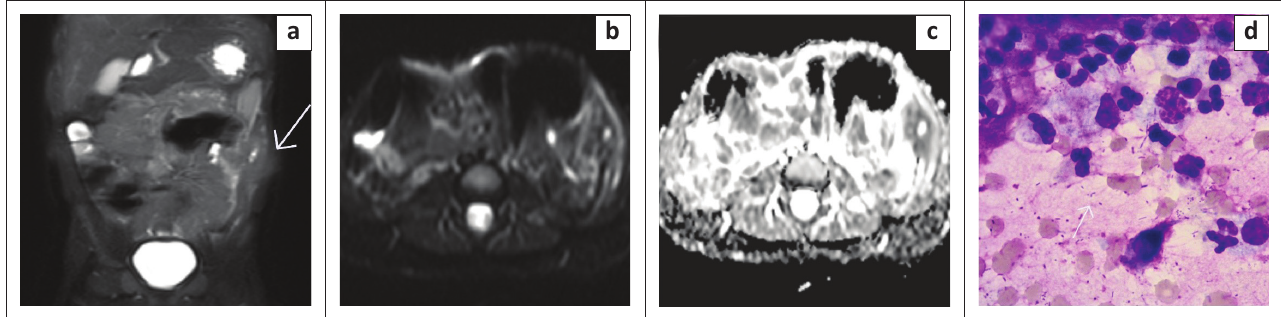
FIGURE 8: (a) MRI images: T2W coronal image illustrated a heterogenous left flank abdominal wall lesion (white arrow), with a central area of hyperintense signal. The lesion demonstrated restricted diffusion on (b) diffusion-weighted imaging and (d) apparent diffusion coefficient. This lesion, initially suspected to be a mass, was subsequently confirmed to be an abscess on fine needle aspiration biopsy, with an aspirate of pus. (d) Shows a Giemsa stain showing acute and chronic inflammatory cells with numerous bacterial cocci in the background (white arrow) (Giemsa stain,